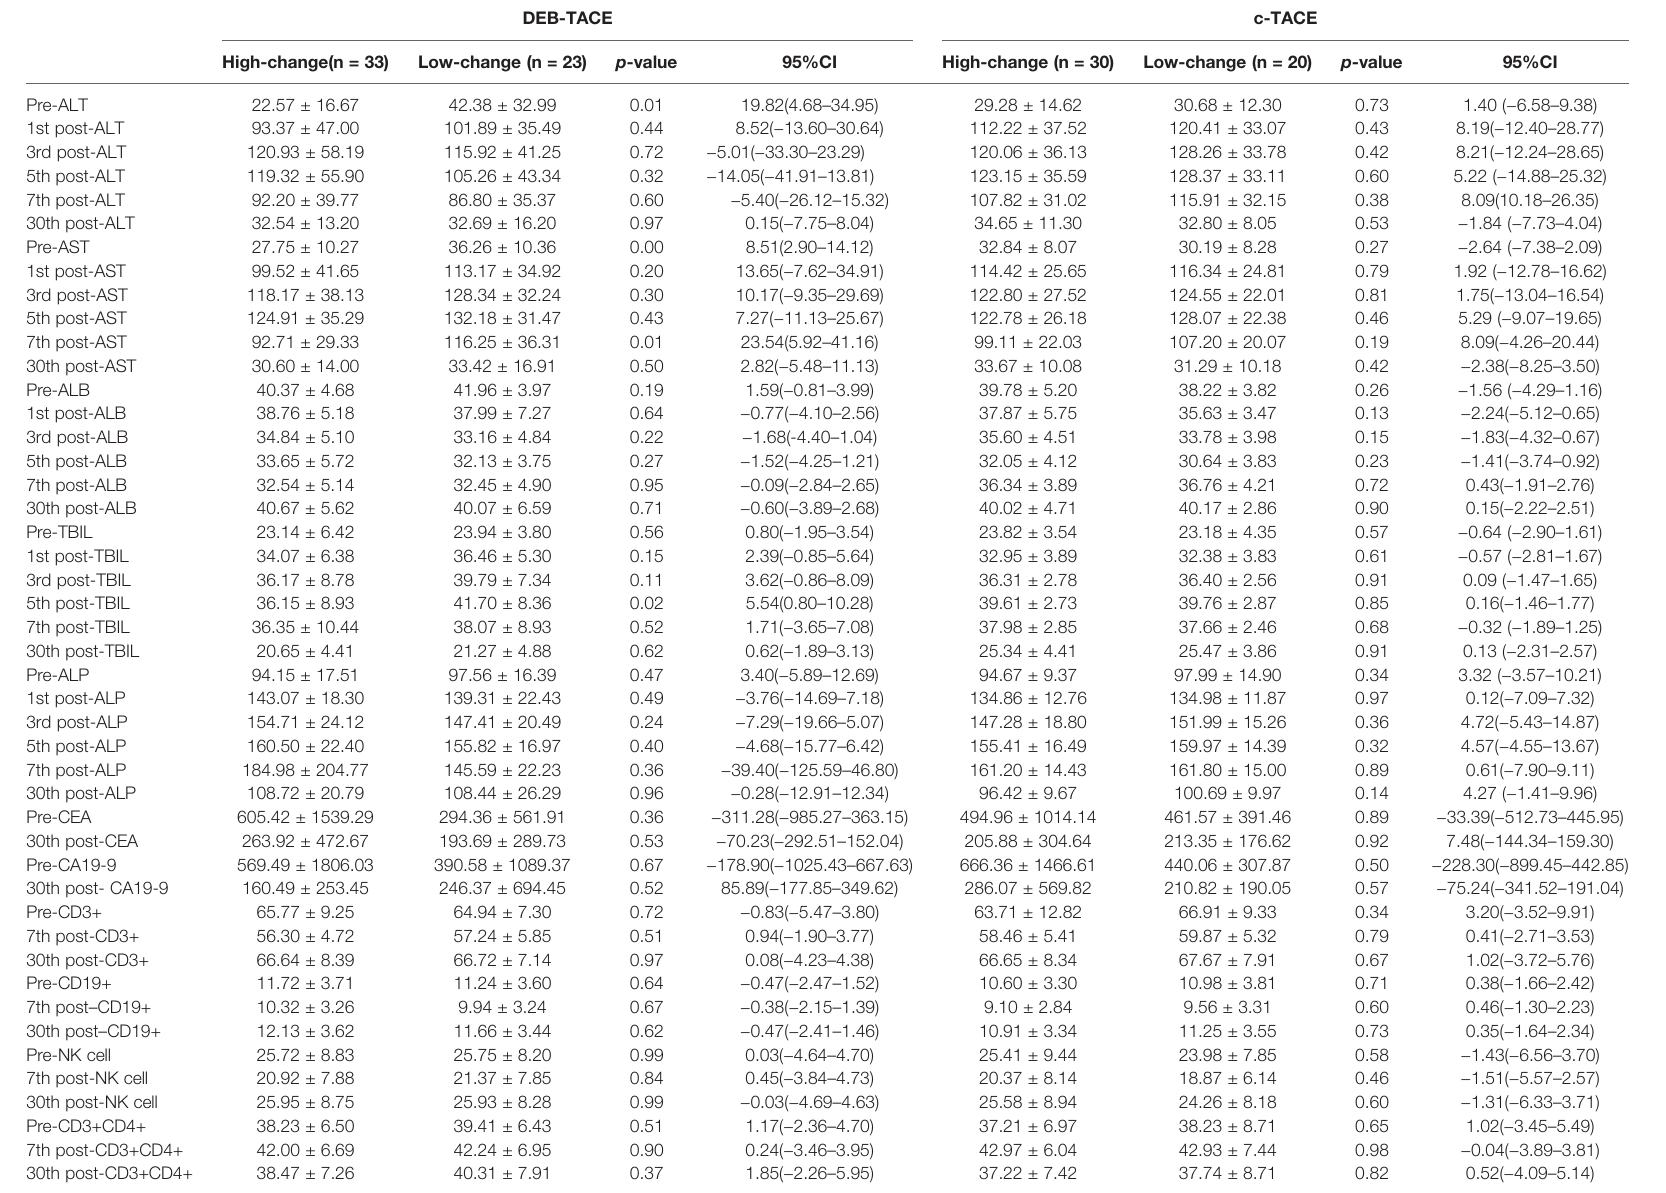
TABLE 5 | Post-expression of HMGB1 group and changes of liver function, tumor marker and immune after